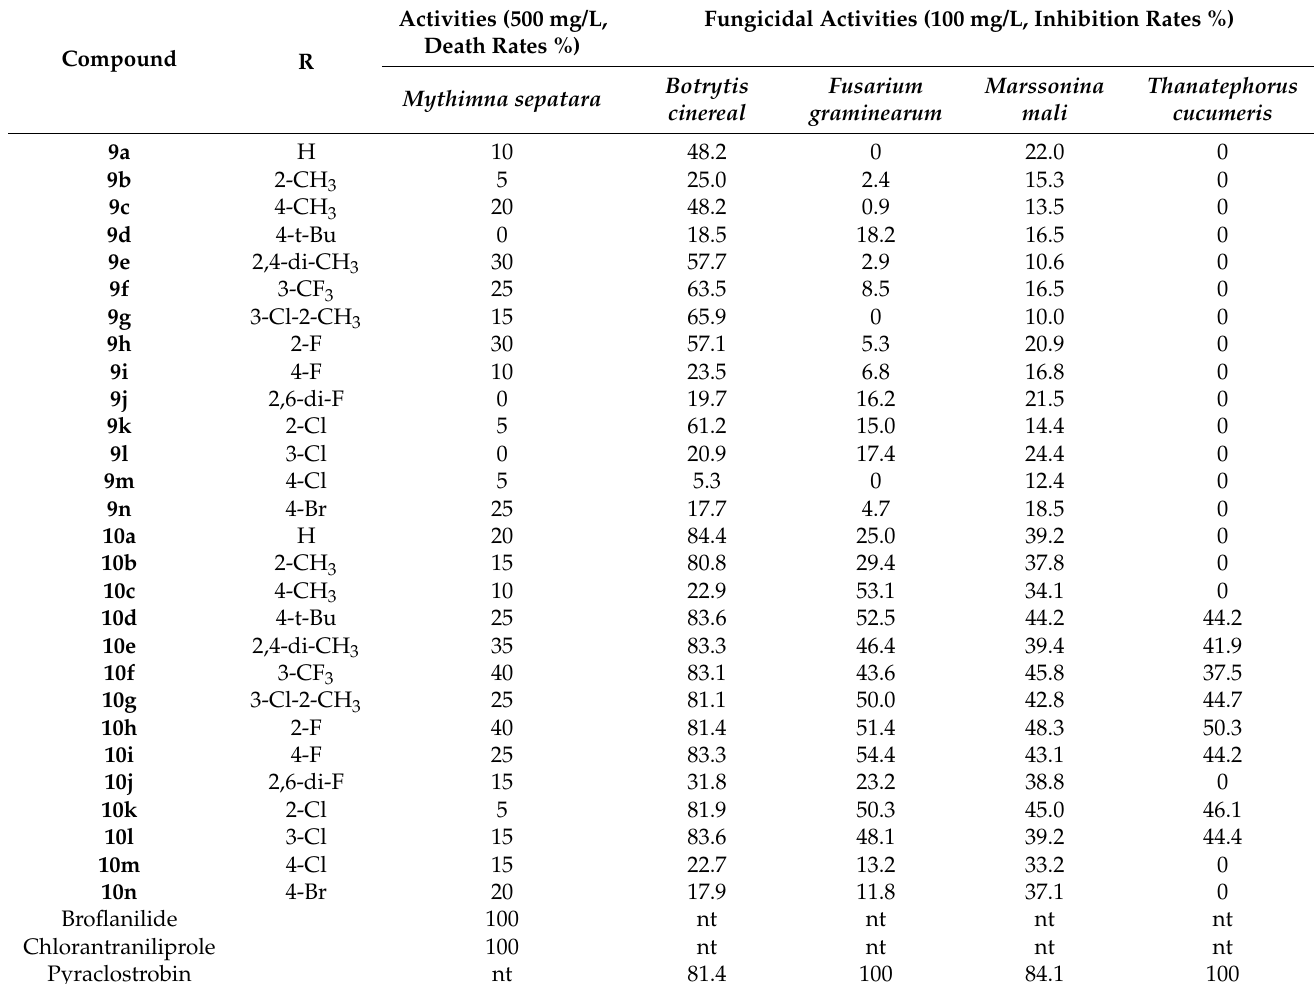
Table 1. Insecticidal and fungicidal activities of title compounds 9 and 10 .